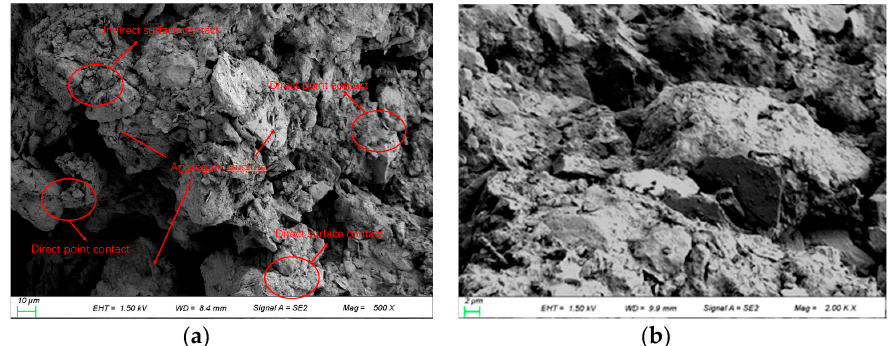
Figure 3. Particle contact state before MICP curing. ( a ) 500 times of undisturbed loess; ( b ) 2000 times of undisturbed